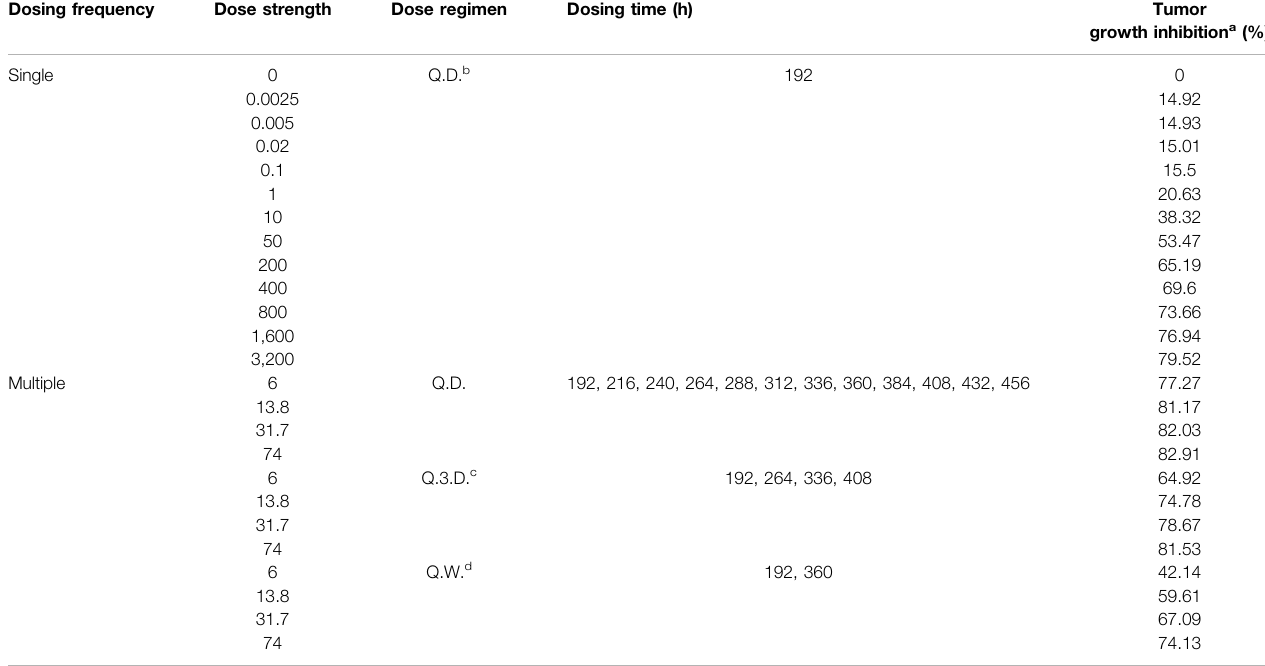
TABLE 2 | Final melanoma syngeneic mouse K-PD model simulation scenarios and results.